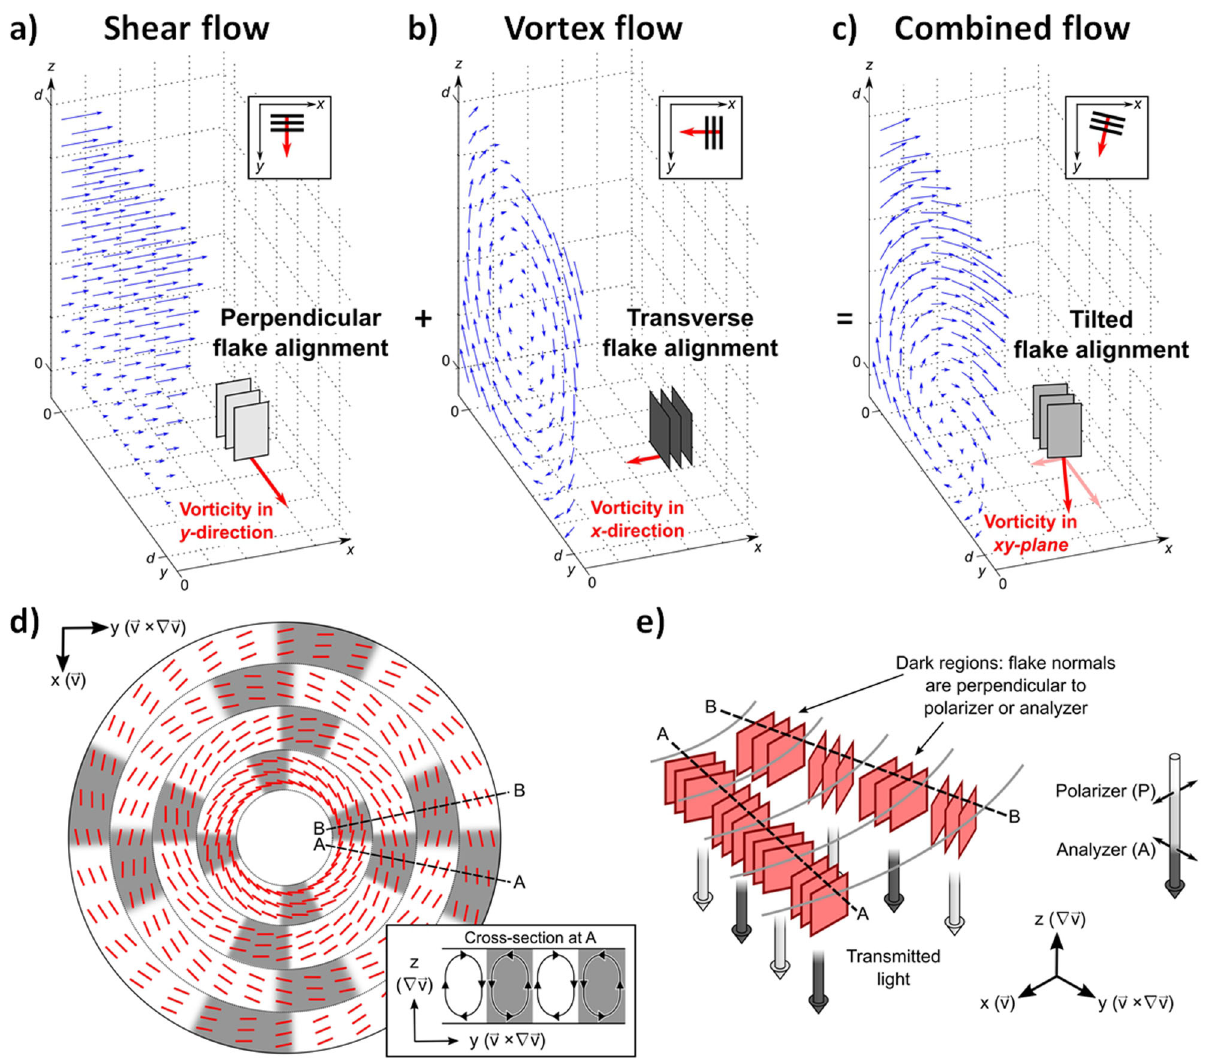
Fig. 3 Mathematical vector fi eld model. Mathematical vector fi eld model was developed to describe the behavior of GO fl akes under a shear fl ow, b vortex fl ow and c combined shear and vortex fl ows. Upon combination of the two fi elds, the combined fi eld is helical and produces vorticity in the x – y plane (Fig. 1c). d Top-view fl ake alignment depicting fl akes aligned with their normal vector in the vorticity direction under combined fl ow. The presented pattern is the outcome of the mathematical fl ow fi tting and matches well with the offset Maltese cross and banding observed in the polarized light image. Inset: cross-section at line A showing the counter-rotating vortex fl ows responsible for the fl ake tilts e Isometric 3D depiction of the cross-sections at lines A and B in part d, demonstrating how dark regions result from fl akes aligned with their normals perpendicular to the polarizer or analyzer direction. The z -scale of the proposed vortices has been compressed for clarity, and fl ake dimensions are not